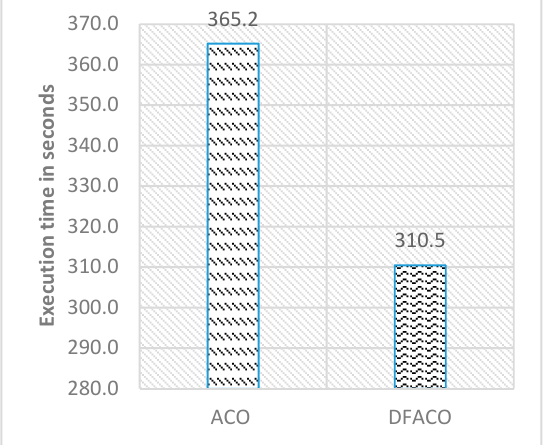
Figure 7. DFACO and ACO comparison in terms of execution time in seconds as shown in Table 2.